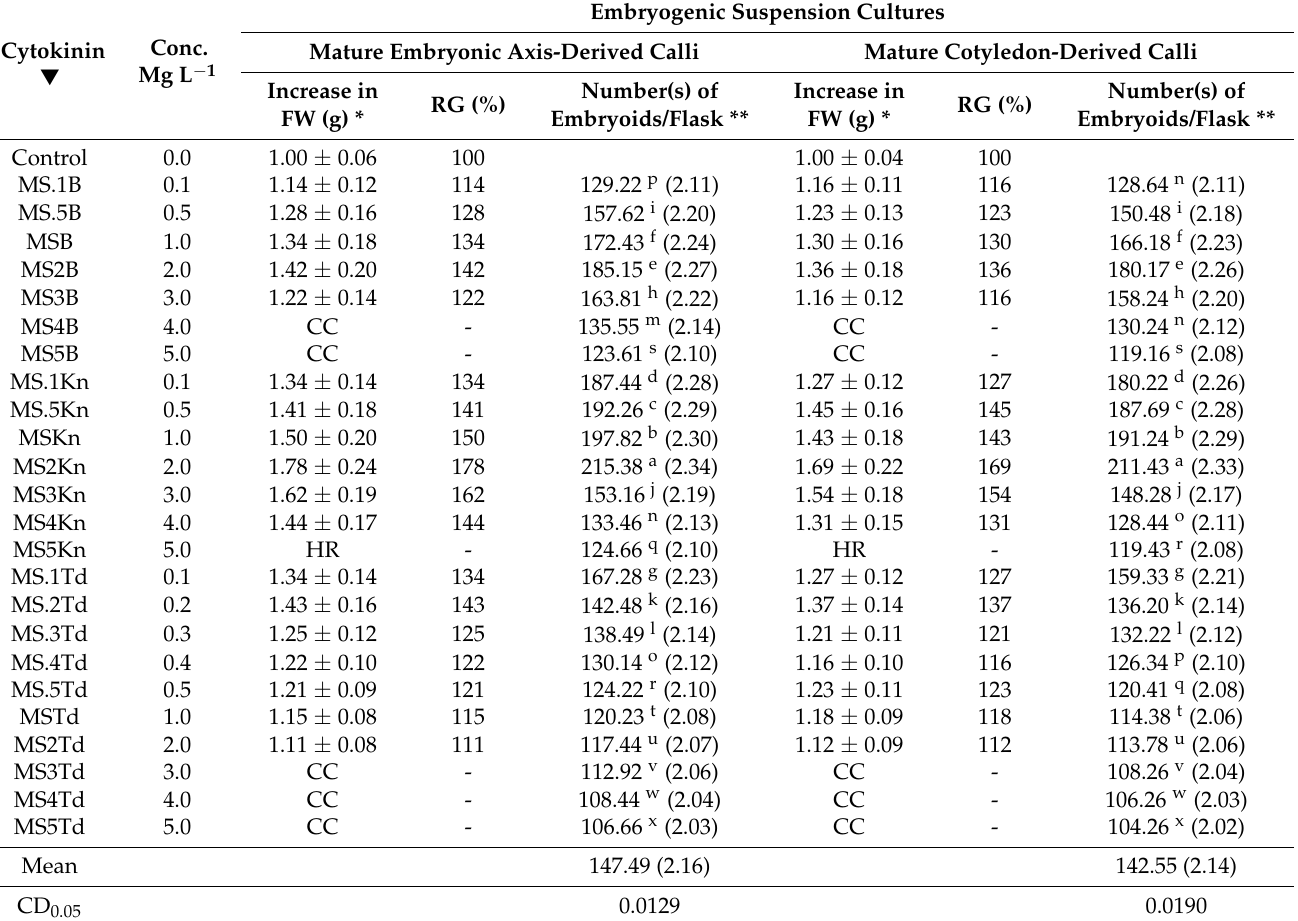
Table 2. Influence of diverse cytokinins (alone) in varying levels on growth of embryogenic cell suspension cultures.